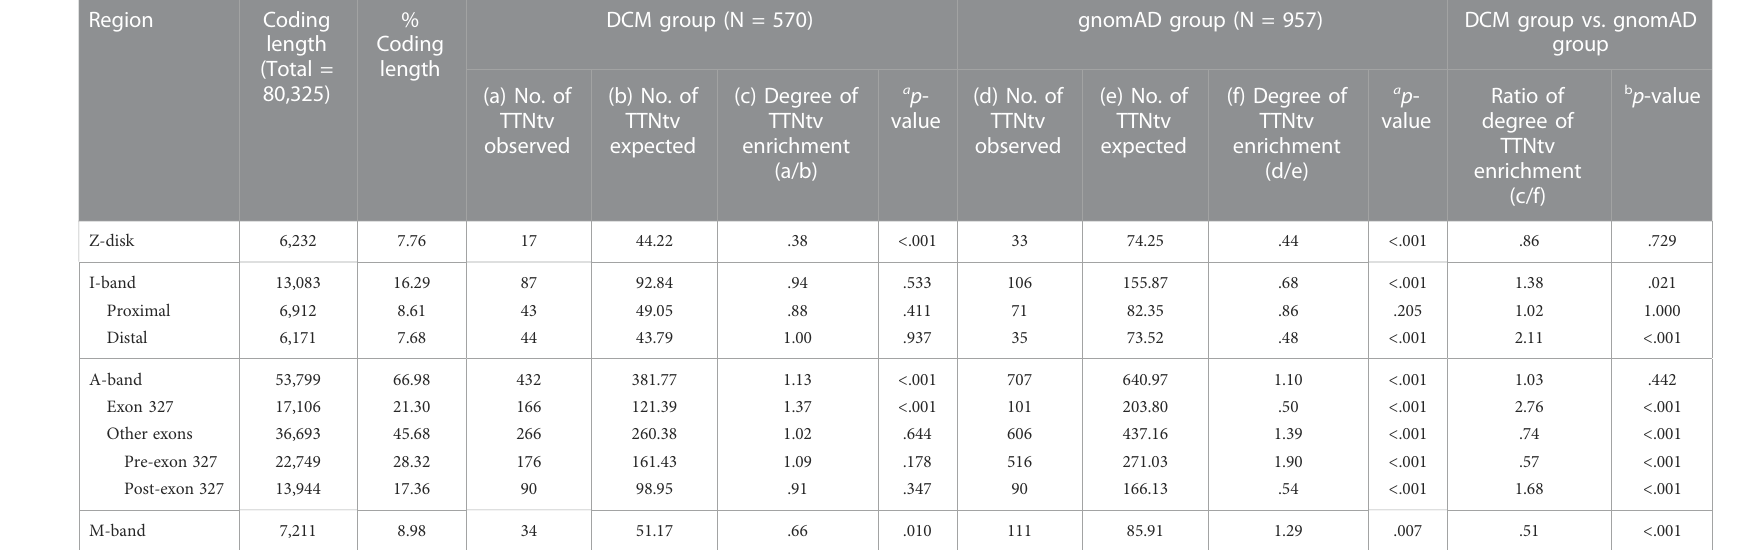
Low-PSI (PSI ≤ .9) exons were removed from analysis, and the coding length and number of TTNtv were derived only from high-PSI (PSI > .9) exons. a p -values were derived from the comparison of the two proportions, % coding length and % TTNtv, using the binomial test. b p -values were derived from the comparison of the two proportions, %TTNtv in DCM group and in gnomAD group, using the binomial test. TTNtv, titin-truncating variant; DCM, dilated cardiomyopathy; gnomAD, genome aggregation database; PSI, percent